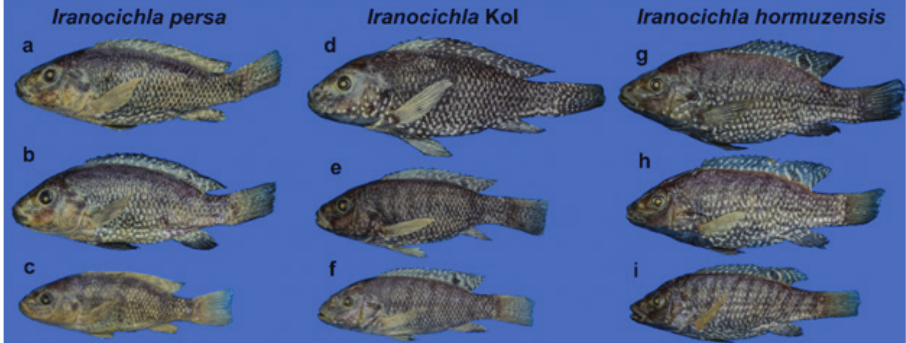
Figure 4. Males of the three Iranocichla taxa from Hormuzgan prov., Iran: Iranocichla persa ; paratypes; a ZM-CBSU-IP75, 86 mm SL b ZM-CBSU-IP78, 82 mm SL c ZM-CBSU-IP69, 67 mm SL; Khorgo Hot spring. Iranocichla from Kol d ZM-CBSU-IP34, 113 mm SL e ZM-CBSU-IP38, 84 mm SL f ZM- CBSU-IH45, 78 mm SL; Kol River drainage. Iranocichla hormuzensis g ZM-CBSU-IH55, 90 mm SL h ZM-CBSU-IH51, 83 mm SL i ZM-CBSU-IH49, 72.2 mm SL; Mehran River